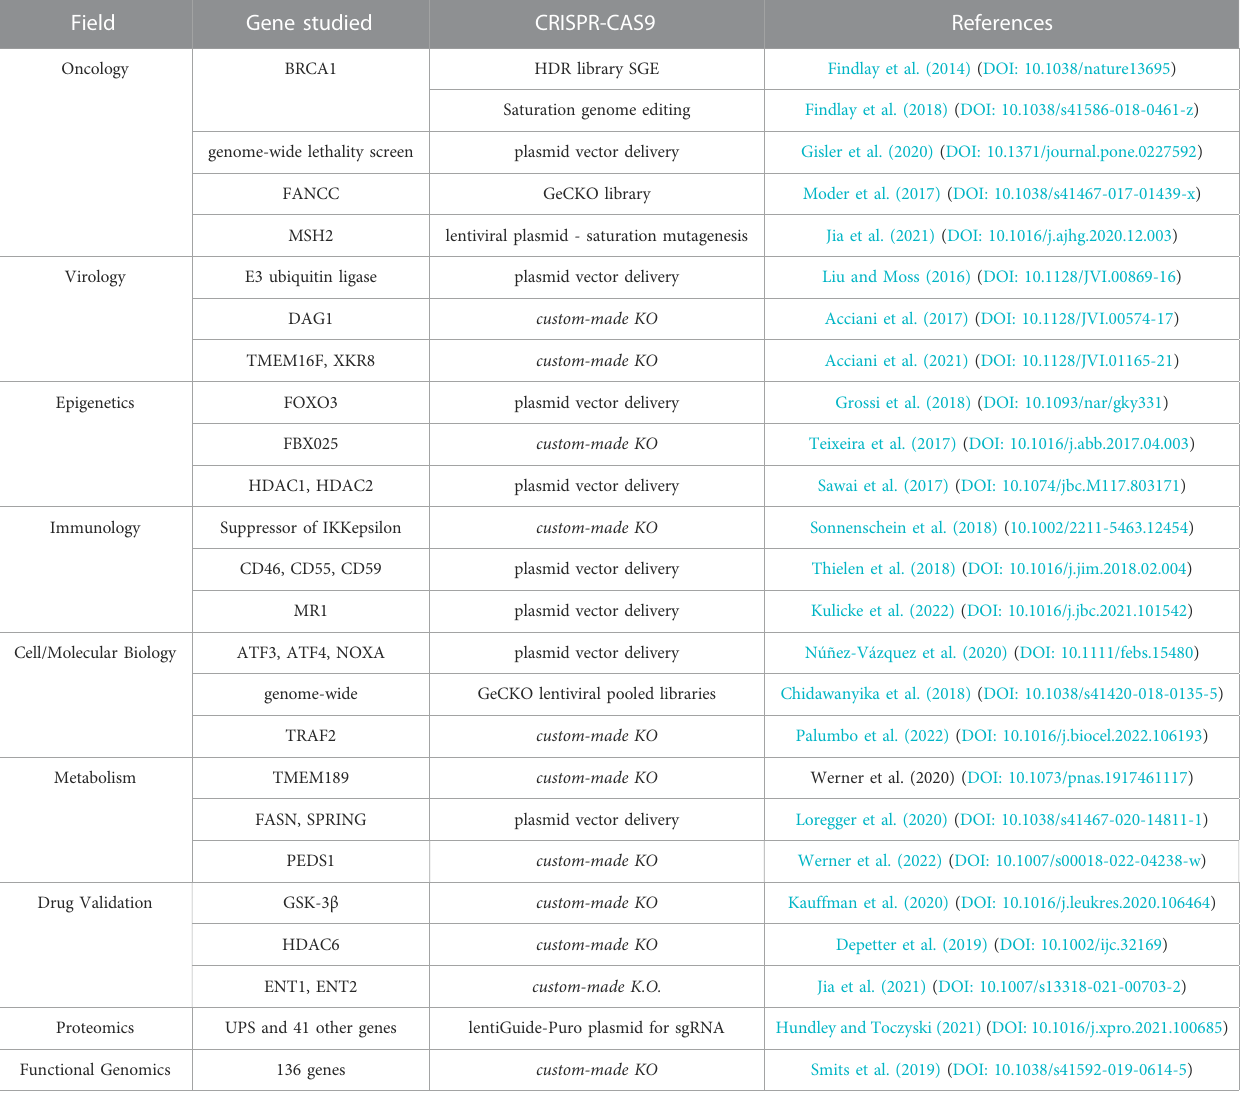
TABLE1SummarytableoffunctionalstudiesusingHAP1.SummaryofsomeofthegenesstudiedusingthehaploidhumancelllinemodelHAP1,classi fi edby fi eld, gene studied and method of CRISPR-Cas9. The full table can be found in Supplementary Table